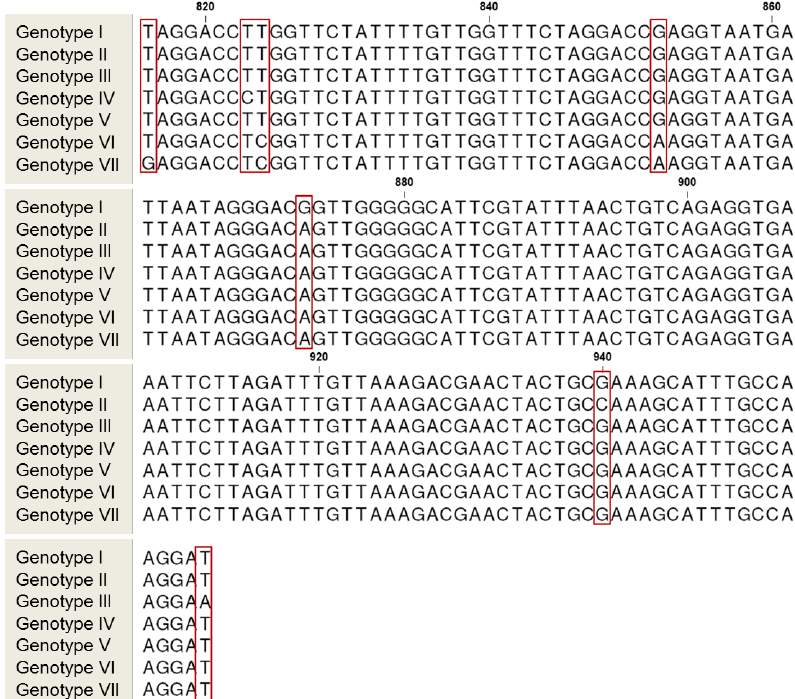
Figure 5. Analysis of polymorphic sites in the Cyclospora cayetanensis 18S rRNA gene. Red boxes enclosed new polymorphic sites identified in the present analyses. Nucleotide positions are based on C. cayetanensis AF111183.1 numbering.